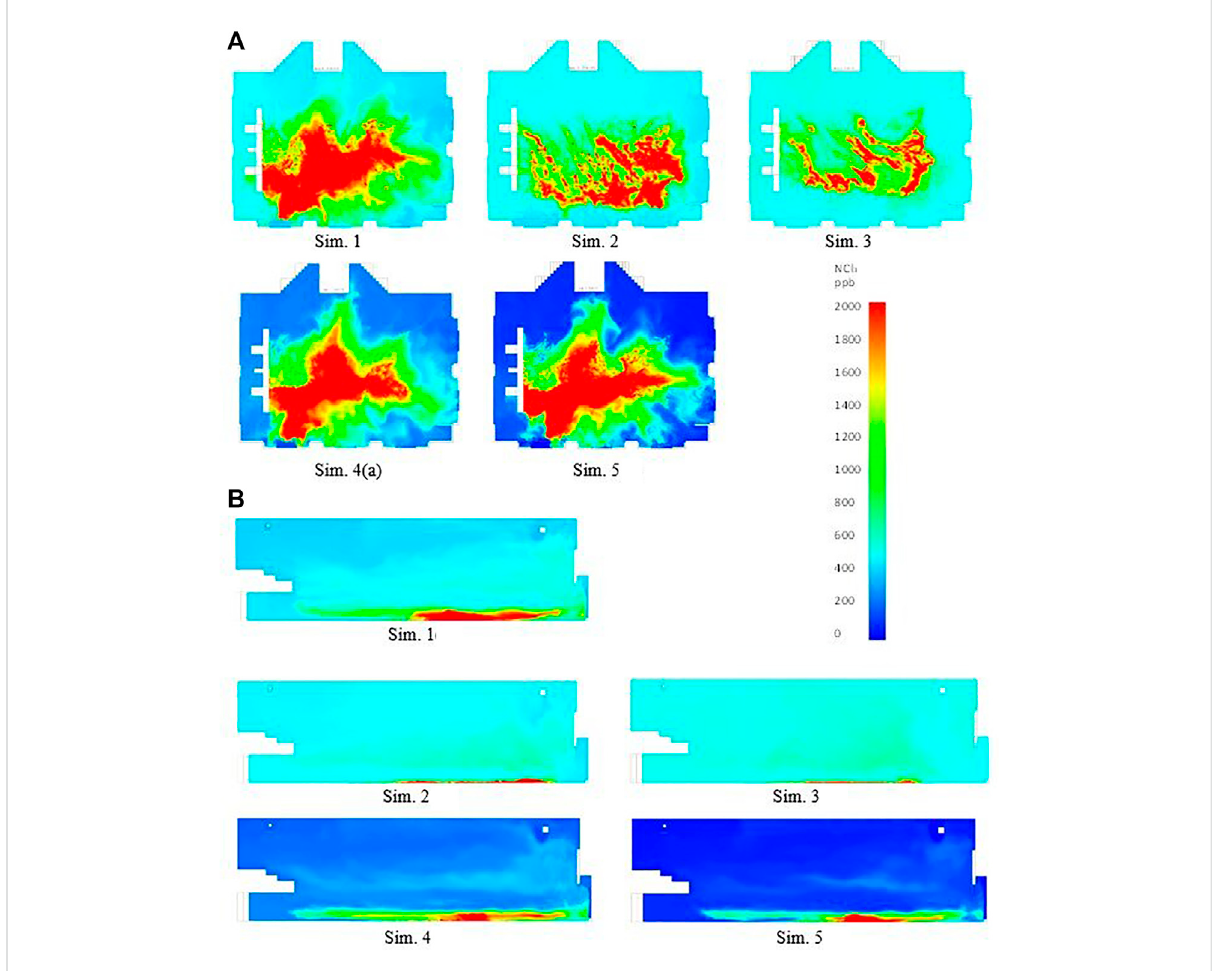
FIGURE 9 C NCl3 (A) in the XY plane at the water level (Z = 0.13 m) and (B) in the YZ plane in the center of the pool hall (X = 21.0